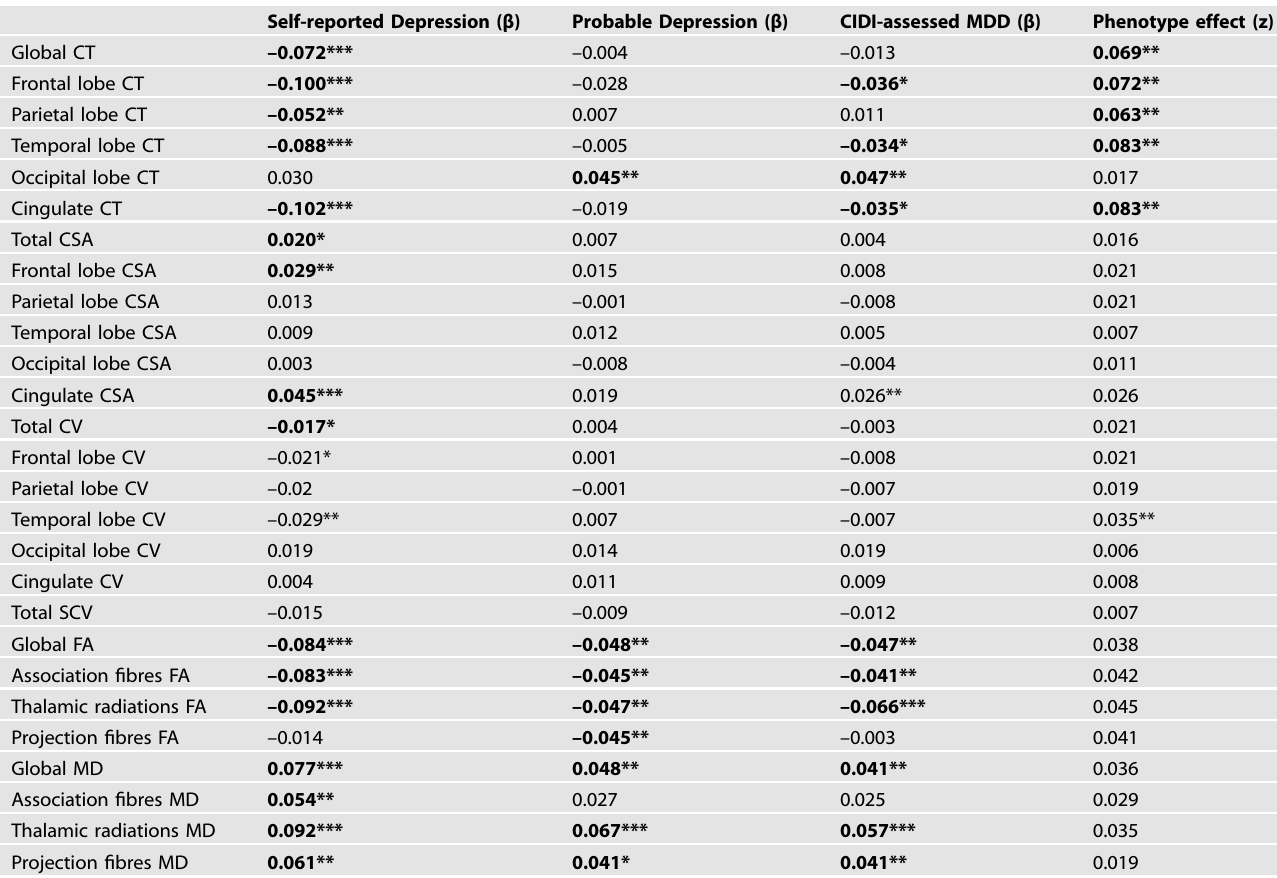
Table 2. Associations between lifetime depression phenotypes and structural metrics for the whole brain, cortical lobes and white matter tract